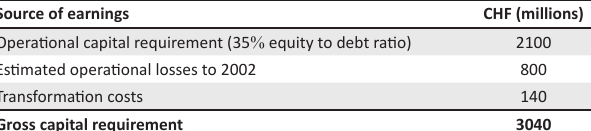
TABLE 7: Capital requirements for the new SWISS International Air Lines. Source of earnings CHF (millions)